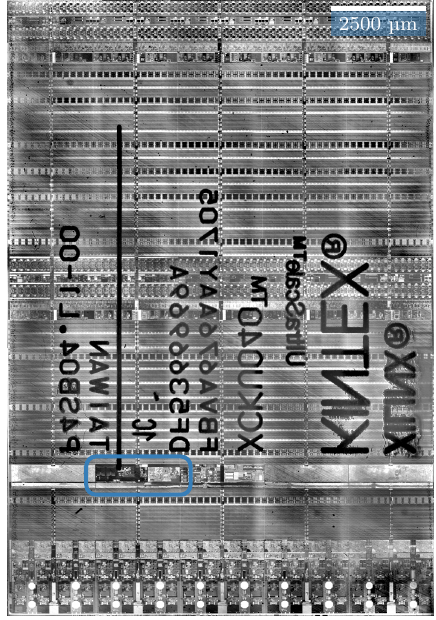
Figure 7: Overview reflected light image of the Xilinx Ultrascale XCKU040 die. The area containing the configuration and decryption logic is